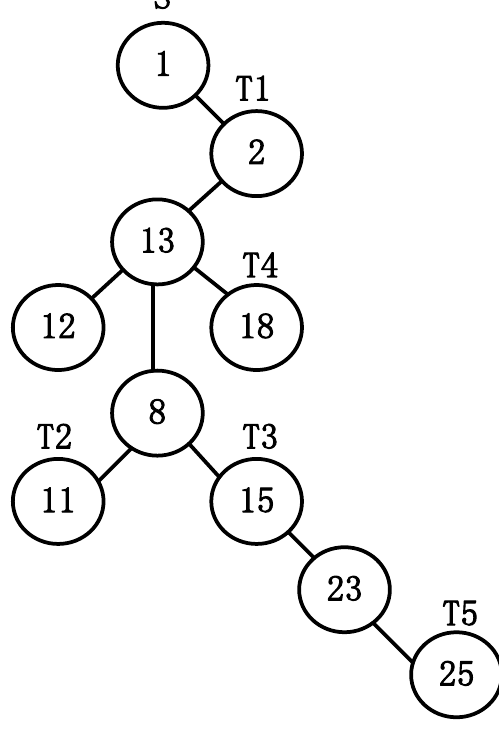
Figure 3. The tree-shaped